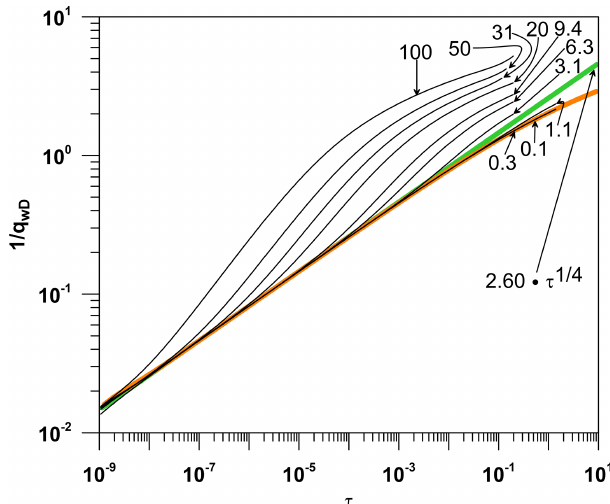
Figure 2. Model results displayed as 1 /q wD vs. τ on a log–log scale. Bilinear fit curve (green line), master curve (orange line), and type curves (black